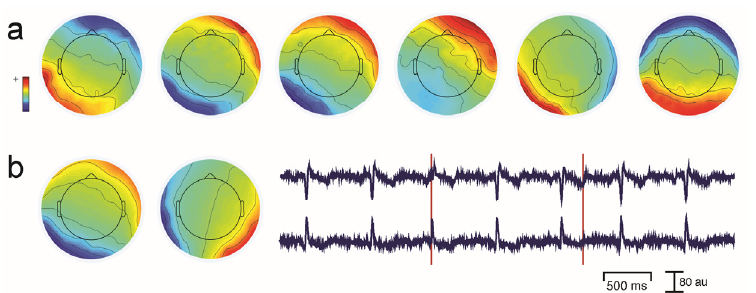
Figure 3. Topography and time course of the electrocardiographic (ECG) artifact. ( a ) Topographic maps (six subjects) showing the characteristic topography of ECG artifacts in EEG data as identified with independent component analysis (ICA) (see also the text in the “Preprocessing and Analysis” section for more detail on the method). A diagonal distribution, with a gradient from the left posterior scalp (where the ECG signal is typically maximal) to the right frontal scalp (e.g., see the first four subjects on the left) is seen. The exact artifact topography depends on the position of the cardiac source in the chest. Some individual variation in scalp ICA maps (e.g., see the last two subjects at the right) can be seen. The color scale depicts arbitrary units. ( b ) On rare occasions, the artifact appears in two separate ICA components, as shown in the data of one subject. The ICA maps show the diagonal gradient (left) and an additional component with a different gradient. The ICA time courses of the ECG artifacts (right) show clear QRS complexes in the epoched data traces (red vertical lines separate data epochs). a.u. = arbitrary units.